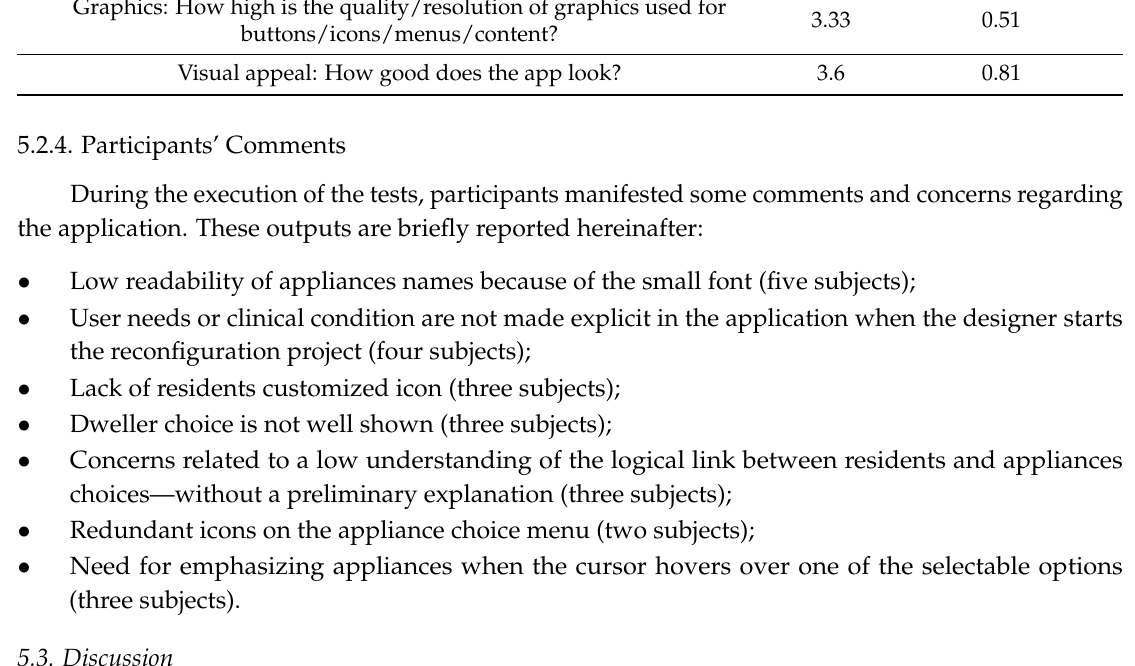
Table 3. The results of the administer Mobile App Rating Scale (MARS)_section C test. Item Mean Standard Deviation Layout: Is the arrangement and size of buttons/icons/menus/content on 3.16 0.75 the screen appropriate or zoomable if needed? Graphics: How high is the quality/resolution of graphics used for 3.33 0.51 buttons/icons/menus/content? Visual appeal: How good does the app look? 3.6